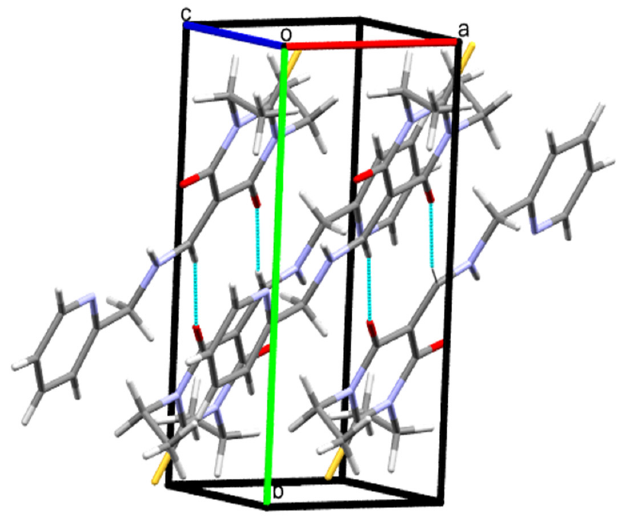
Figure 3. Crystal packing diagram of compound 1 .